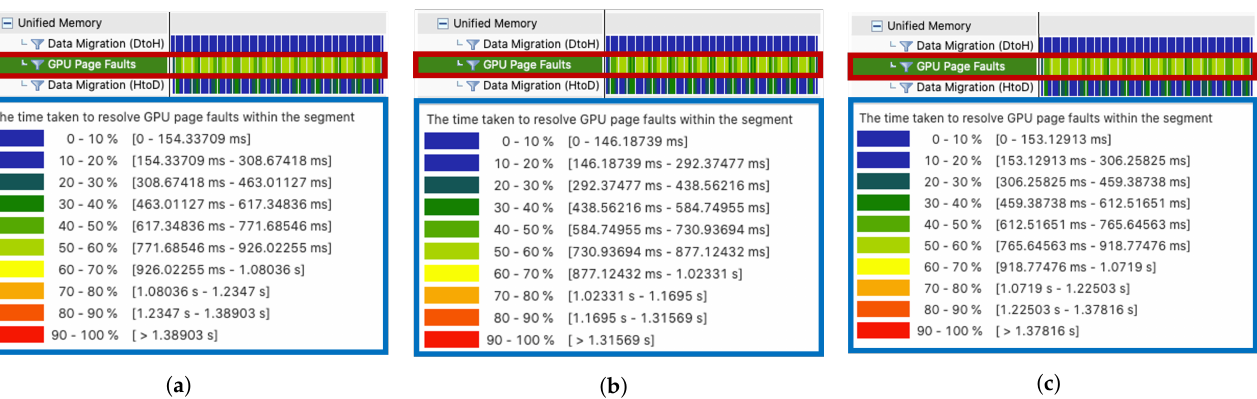
Figure 10. This is a visualization of the profiling results using the NVIDIA Visual Profiler: ( a ) The profiling result when memory advise is not set; ( b ) A visualization of the profiling results when configured with memory advise that shows the best performance; ( c ) A visualization of profiling results when configured with memory advise, which shows the worst performance.